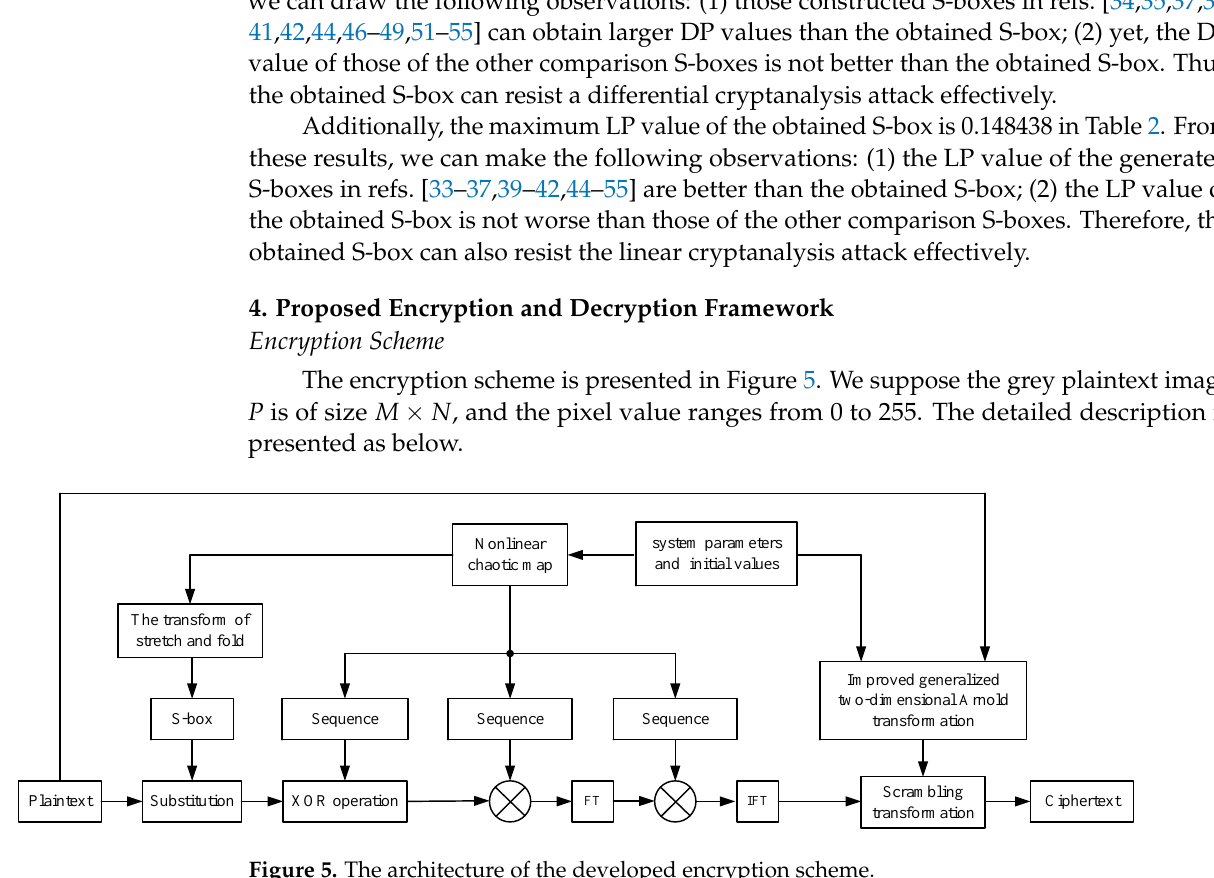
Figure 5. The architecture of the developed encryption